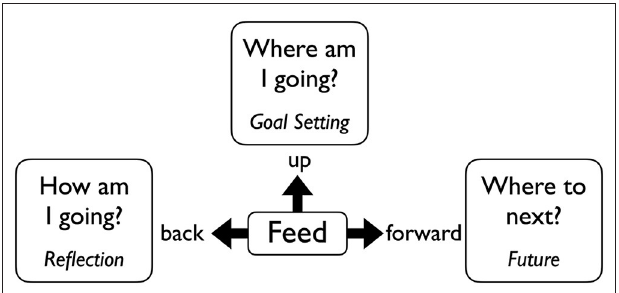
FIGURE 1 | Visual depiction of feed back, feed up, and feed